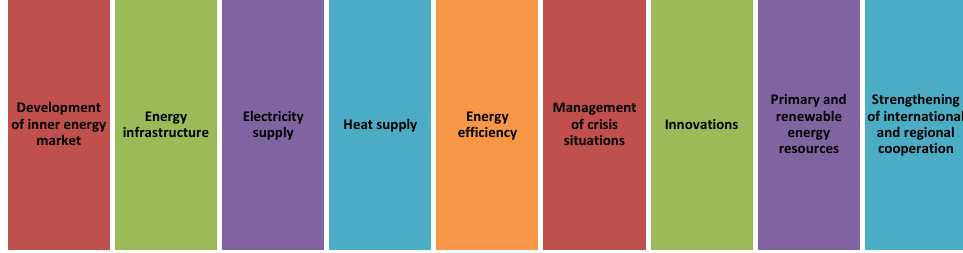
Fig. 9. Main directions of tasks to be performed in the power industry from 2016 until 2020.